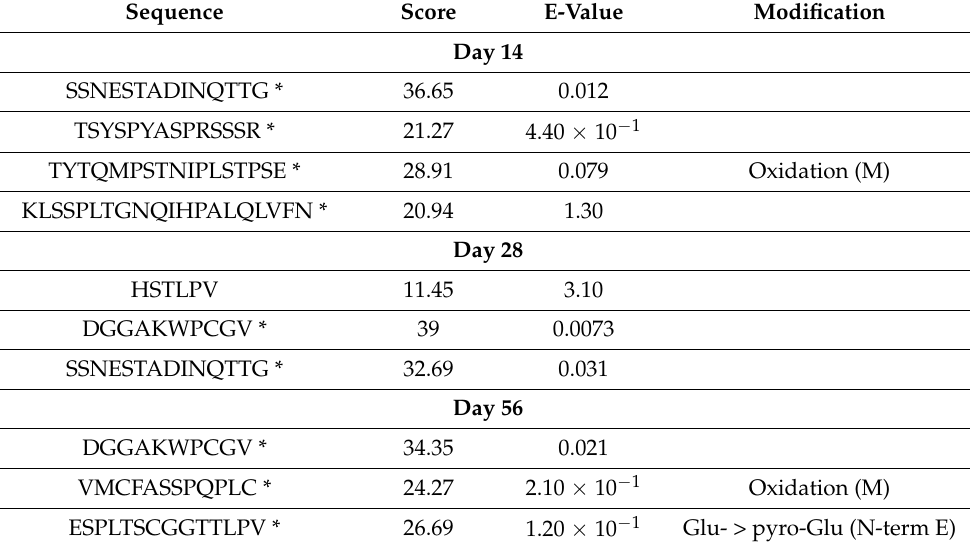
Table 3. The identified peptide sequences of S. mekongi ubiquitin thioesterase trabid from 14, 28, and 56 days after infection.